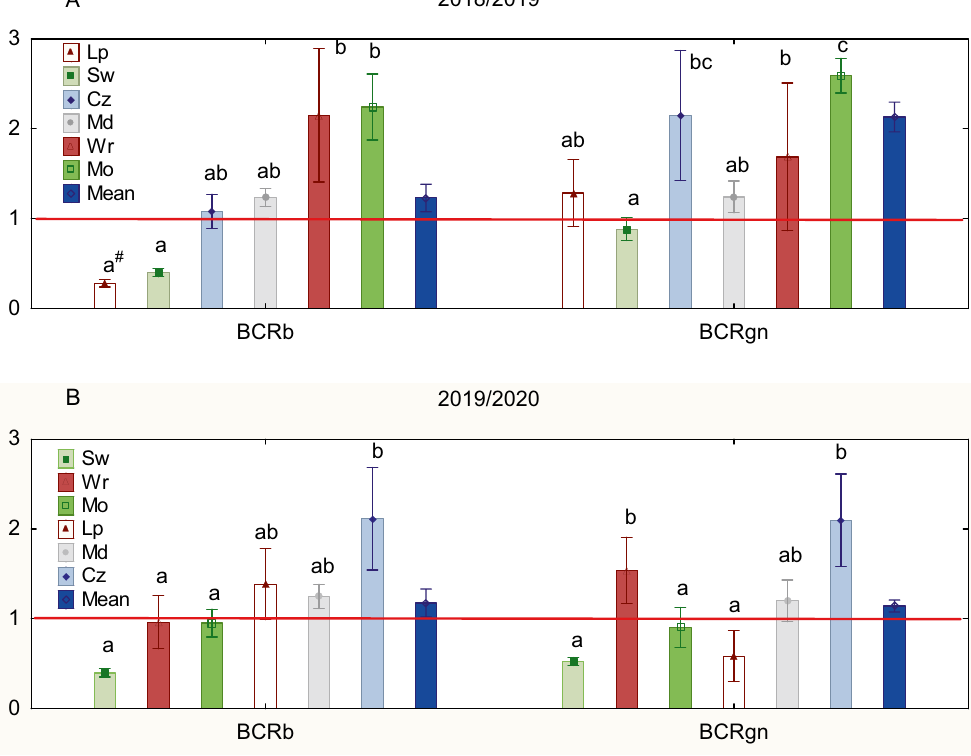
Figure 2. Competitive ratio for plant biomass (BCRb) and grain (BCRgn) between susceptible and herbicide- resistant blackgrass biotypes in the years of study for six sites in Poland. Mean ( n = 6) ± standard error. Competitive ratio values < 1 indicate that the herbicide-resistant biotype of blackgrass is more competitive than the susceptible